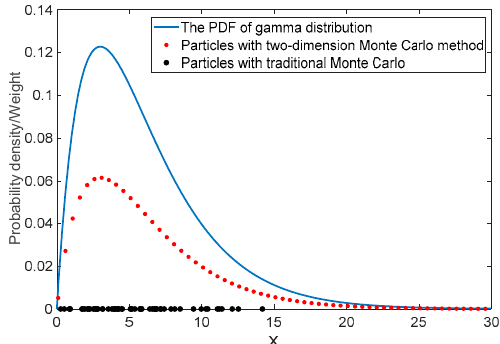
Figure 3. Sampling results from TMC and MC.